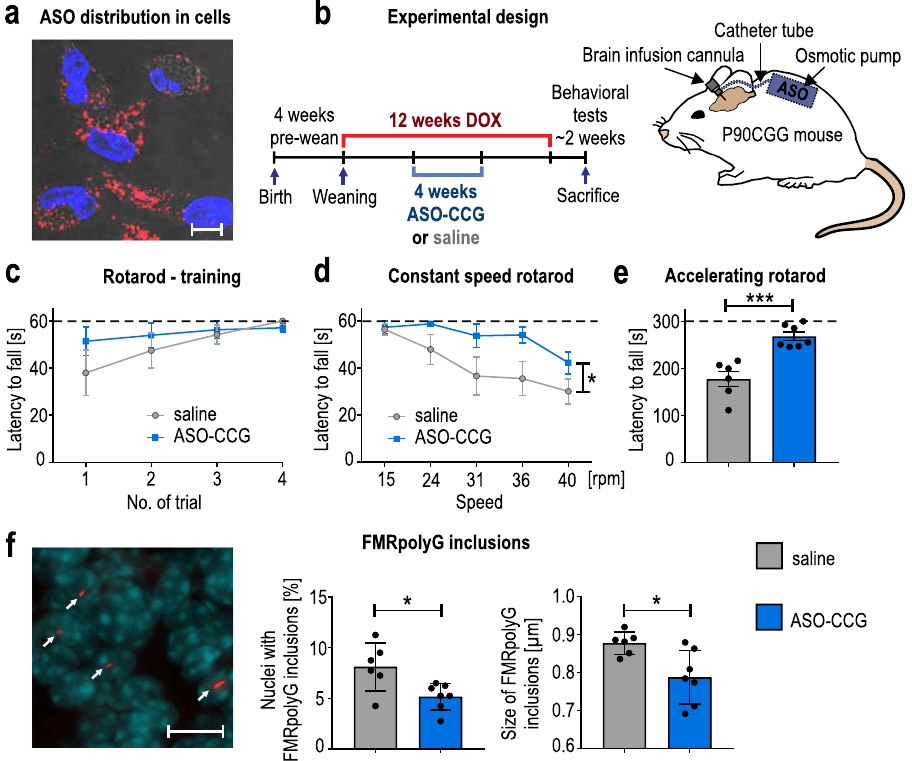
Fig. 4 The effect of ASO – CCG on behavioral and molecular phenotypes in the FXTAS mouse model. a Representative image showing the distribution of ASO – CCG-Cy3 (red; 200 nM) in COS7 cells. ASO entered cells in the absence of a carrier. Blue, stained nuclei; scale bar, 20 µ m. The experiment was repeated two times with similar results. b Experimental design for DOX induction (red) and ASO – CCG delivery (blue) into P90CGG mice. The contents